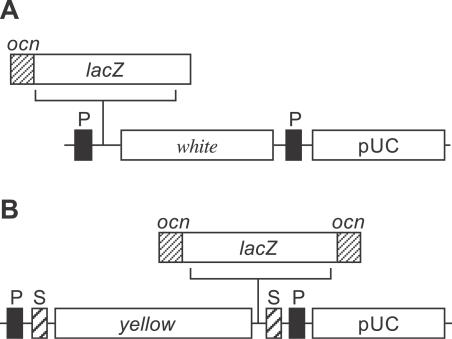
Schematic Diagram of the ocn-lacZ Expression Constructs(A) The pP[wFl-ocn-lacZ] vector. The ocn promoter fused to the lacZ open reading frame was inserted into the pP[wFl] transformation vector, which contains the white gene as a selectable marker. The boundaries of the DNA inserted into the Drosophila genome are indicated by “P”. The portion of the plasmid used for replication in E. coli is labeled “pUC”.(B) The pP[YEStes-lacZ] vector. The ocn promoter and 3′ UTR were fused to respective ends of the lacZ open reading frame and inserted into the YES transformation vector. Binding sites for the Suppressor of Hairy-wing protein, which functions as a chromosomal insulator, are labeled “S”.